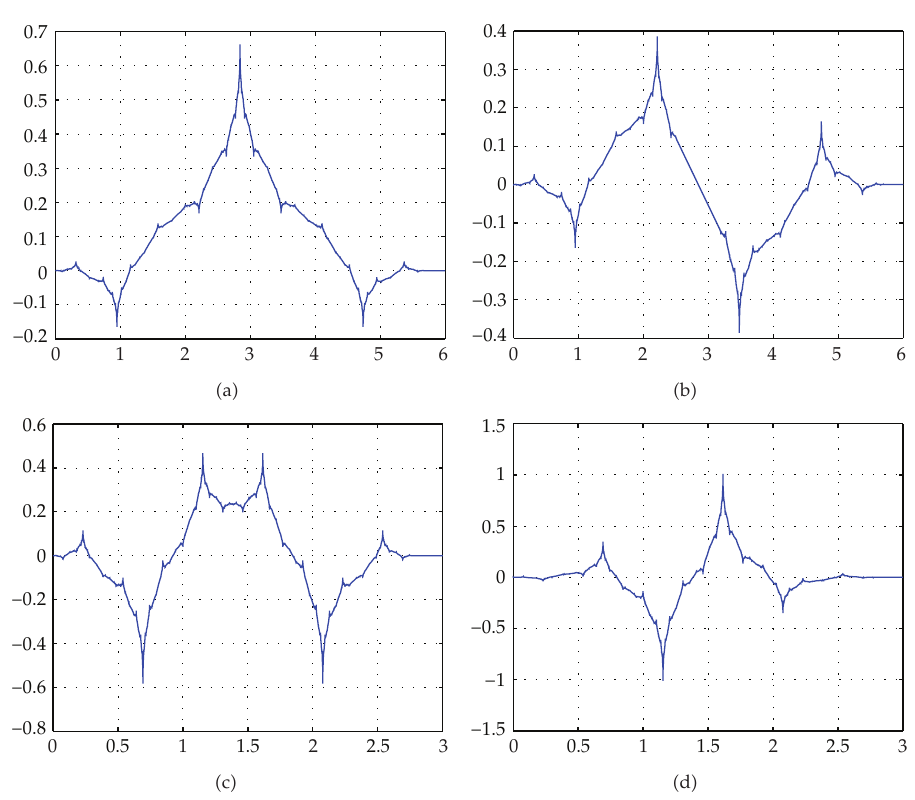
Figure 1: (cid:6) a (cid:7) Refinable function φ ∈ W 0 . 8155 (cid:6) R (cid:7) with symmetry, (cid:6) b (cid:7) framelets ψ 1 with antisymmetry, and